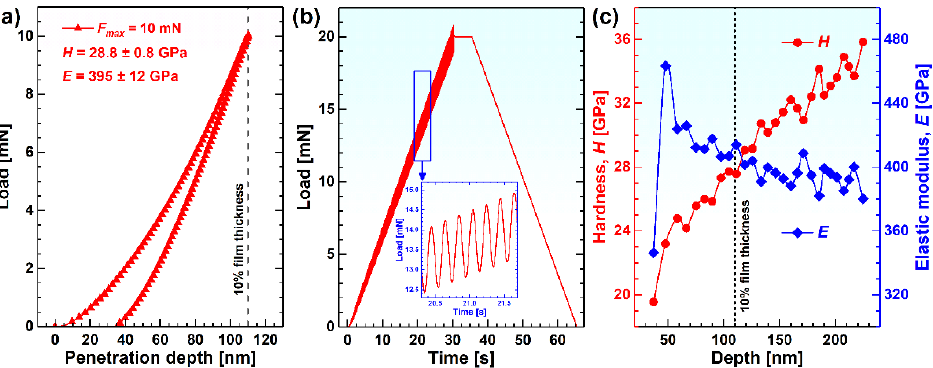
Figure 3. ( a ) Load-penetration depth curves of nanoindentation tests applied on the film surface (constant load mode, max. load 10 mN). ( b ) Load vs. time curve of the penetrated indenter using the continuous stiffness measurement mode. ( c ) H and E values determined by using the CSM mode measurements as a function of the penetration depth.